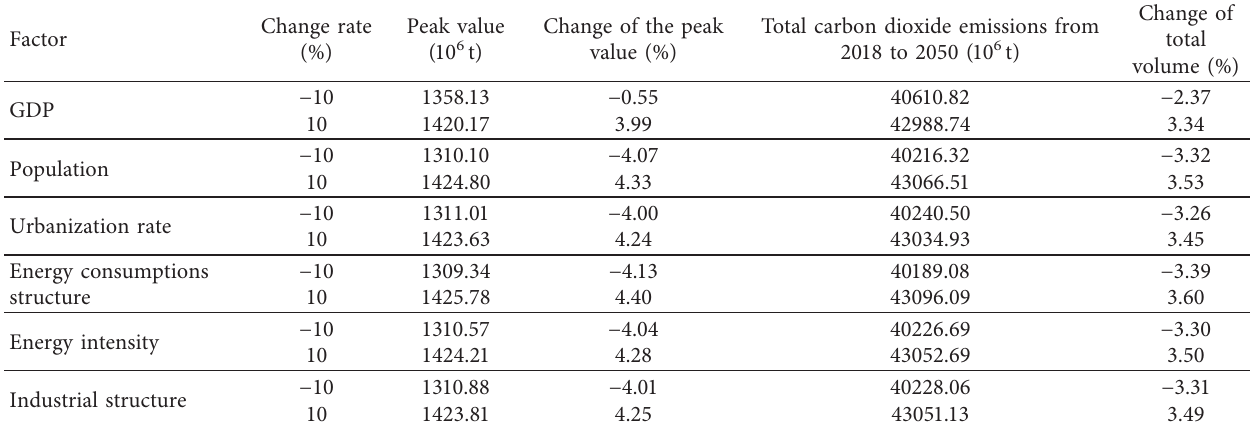
Table 7: Carbon dioxide emissions of each factor at different change